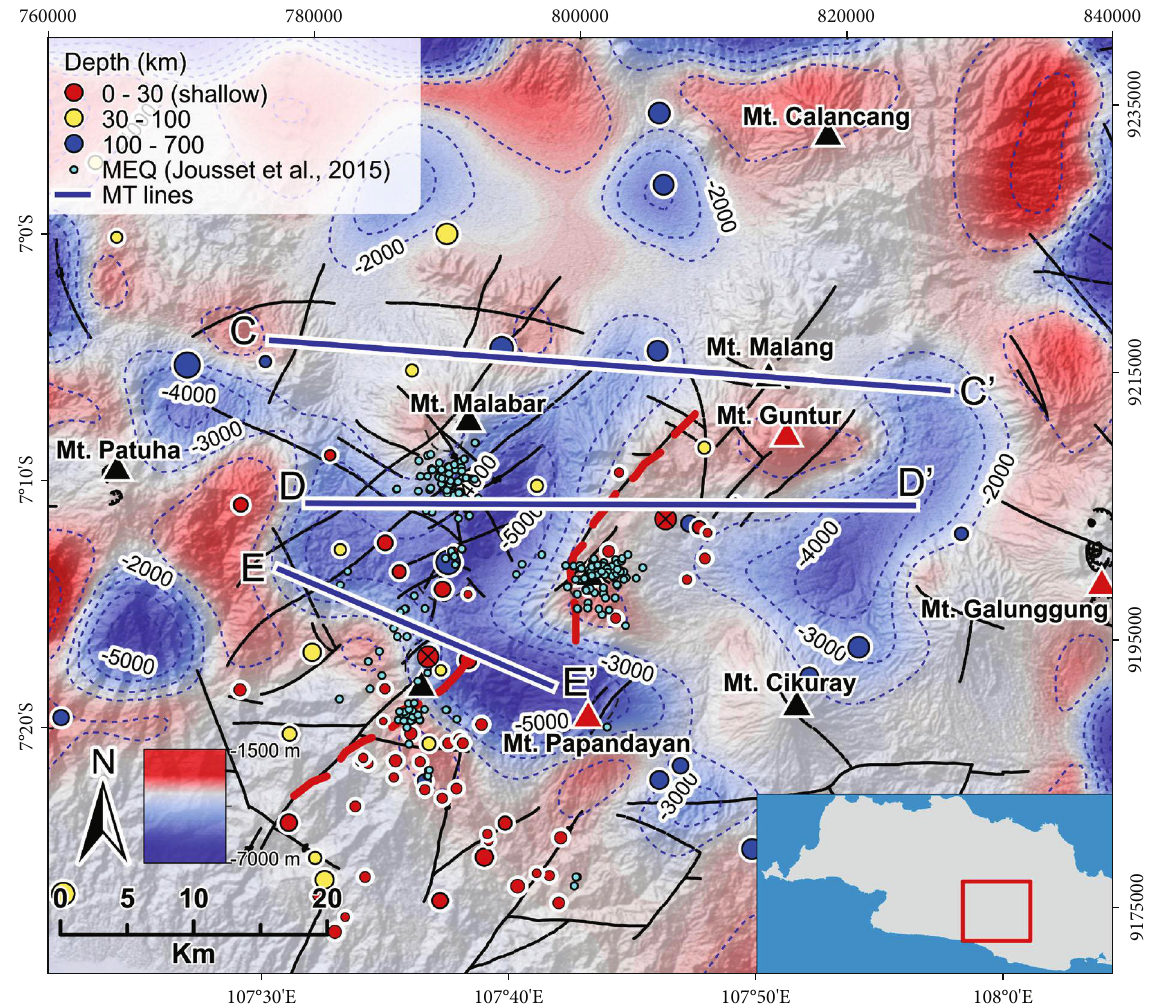
Figure 17: Basement depth map based on the 3D density model using a threshold of 2.525g/cm 3 as the minimum basement